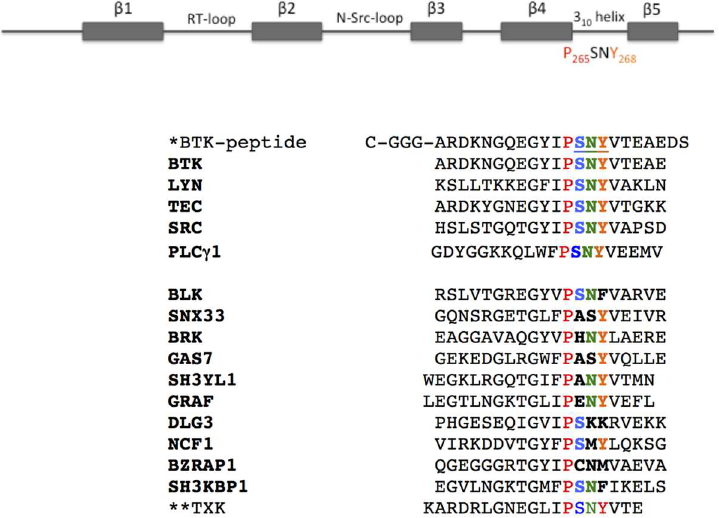
Fig 5. Schematic visualization of the SH3-domain and sequence-alignment of the C-terminal SH3- domains of the ANK54RD-binders identified in the screen. Secondarystructural elements of BTK- SH3-domain and homology alignment of the last 20-amino-acids of the humanSH3-domains, accordingto Ka¨rkka¨inen [25]database.The NCF1, BZRAP1 and SH3KBP1 proteinscontainmore than one SH3-domain and the sequencecorresponds to the SH3-domain bindingto ANKRD54. SNY -amino-acidscreate a right-